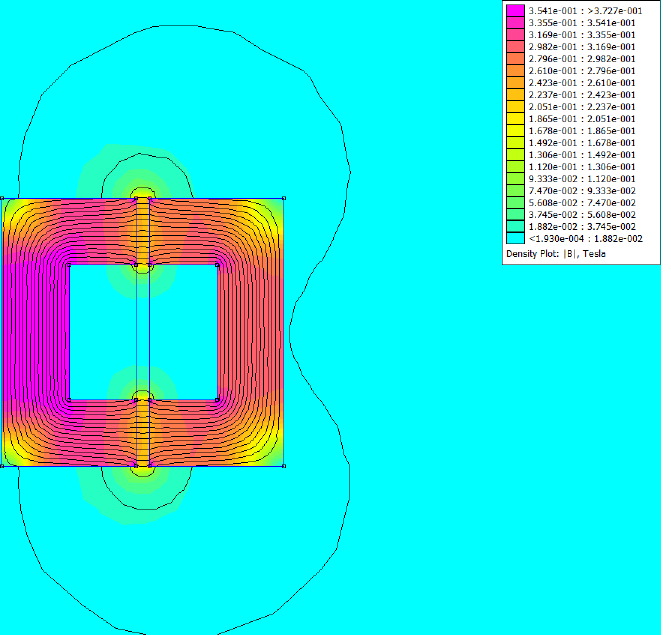
Figure 6. Density plot of the absolute value of the induction field | B | superimposed to the field lines of the real part of the magnetic vector potential ˆ A for a realistic geometrical configuration of the rotary